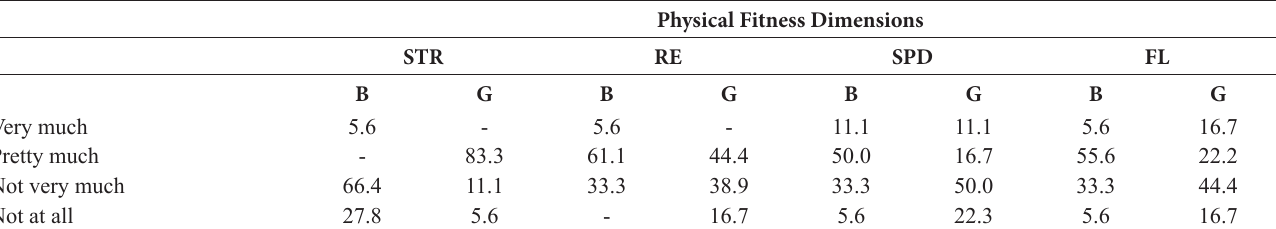
Table 4. Teachers’ opinions about boys’ (B) and girls’ (G) interest (in percentages) in physical fitness. STR = strength, RE = resistance, SPD = speed, FL = flexibility ( n = 18).